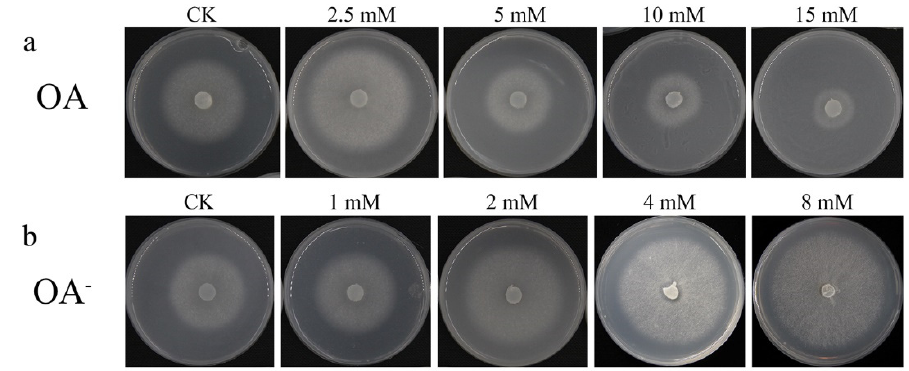
Figure 4. Growth of the S. latifolia mycelium on PDPA. ( a ) Growth of the S. latifolia mycelium on PDPA supplemented with different concentrations of OA; ( b ) growth of the S. latifolia mycelium on PDPA supplemented with different concentrations of OA - .